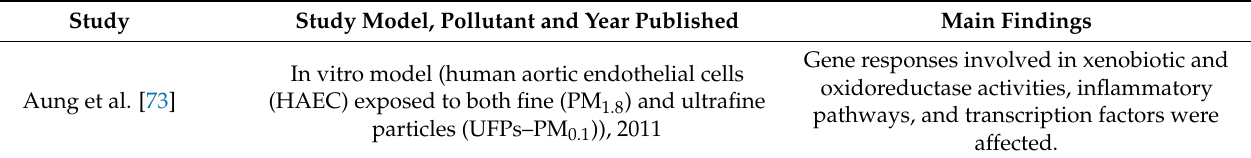
Table 1. Key studies investigating the effects of PM 2.5 on mitochondria in the cardiovascular